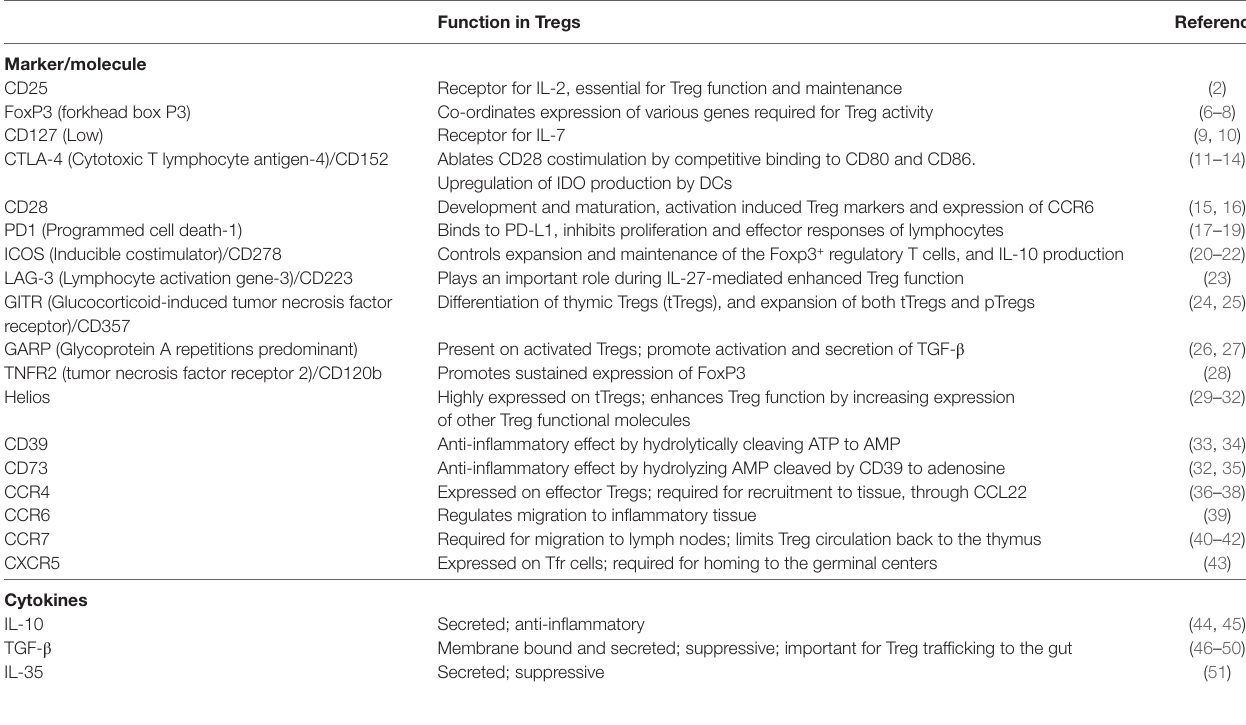
TAble 1 | Key immunophenotypic markers/molecules and cytokines expressed by T regulatory cells (Tregs) and their function. Function in Tregs